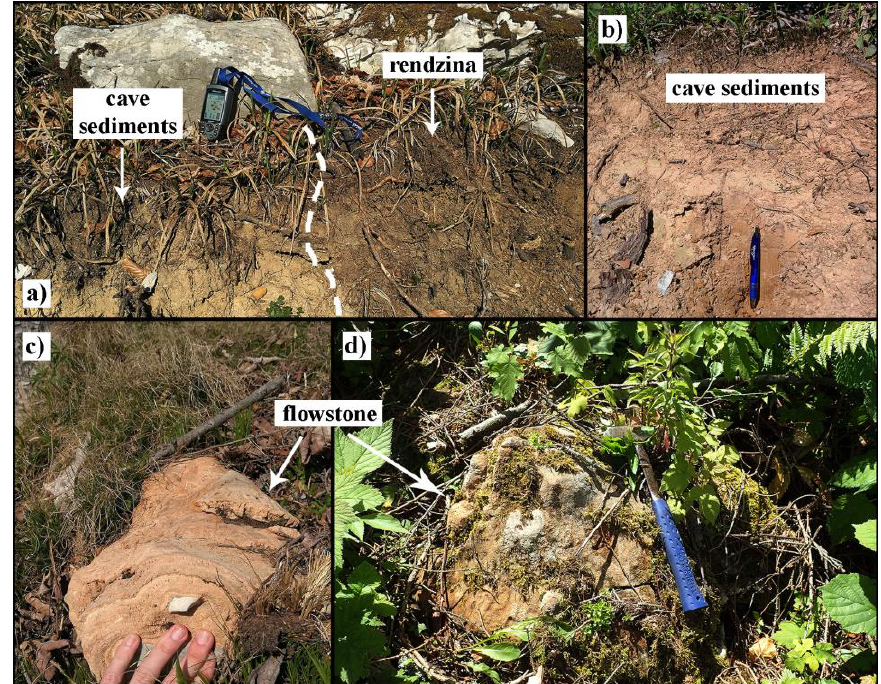
Figure 2. Cave sediments and flowstone as typical indicators for speleogenesis: ( a ) Comparison of the colour difference between cave sediments and soils on carbonate rocks (rendzina); ( b ) Closer view of the cave sediments; ( c ) Cave sediments are accompanied with occurrences of flowstone in some places; ( d ) Outcrops of flowstone are often covered with moss, making it easier to recognize them compared to outcrops of limestones.